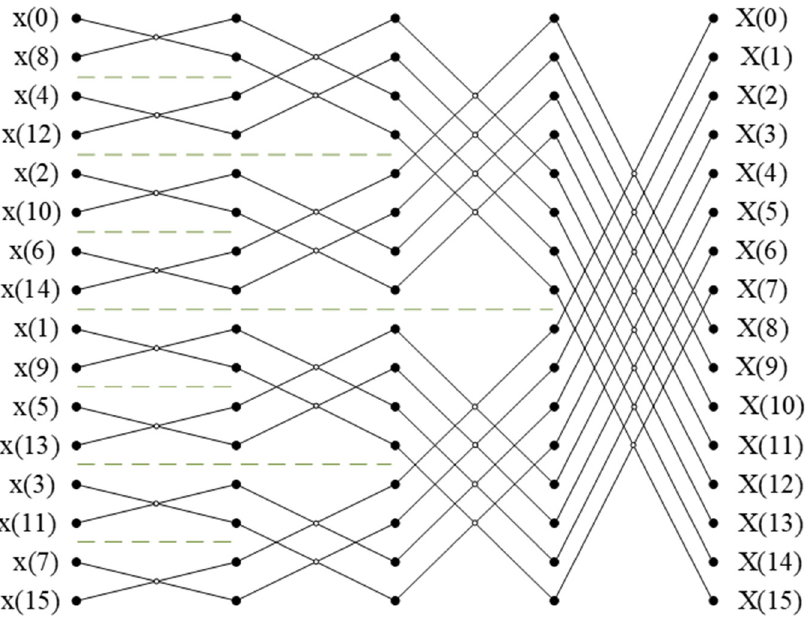
Figure 2. Calculation flow diagram of FFT.